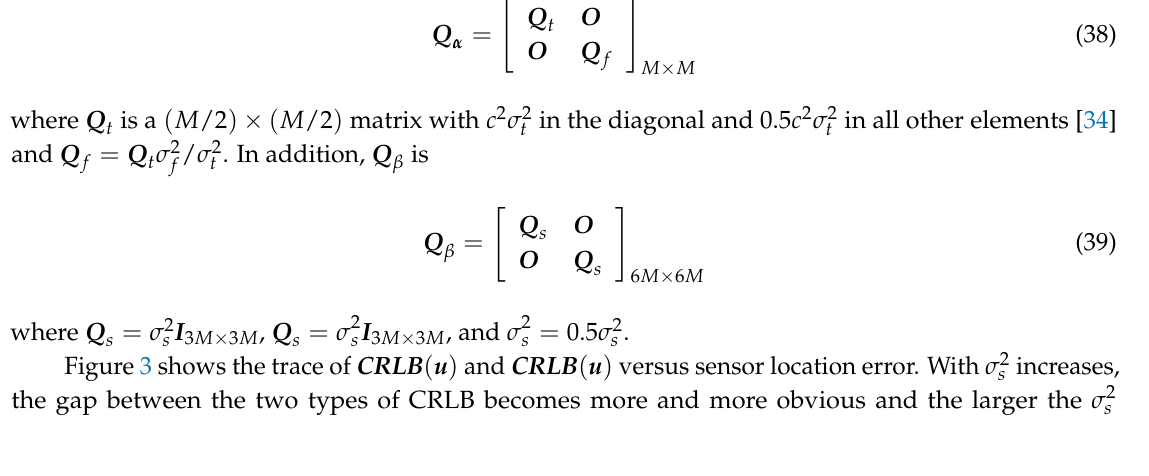
( b ) Figure 3. CRLB comparison versus sensor location error. ( a ) The near-field moving source; ( b ) The far-field moving source.